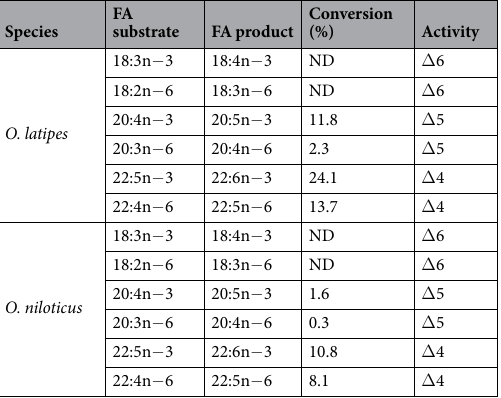
Table 2. Substrate conversions of Saccharomyces cerevisiae transformed with Oryzias latipes and Oreochromis niloticus fads2 coding region and grown in the presence of one exogenously added fatty acid (FA) substrate formula [product area/(product area + substrate area)] × 100. ND, Not